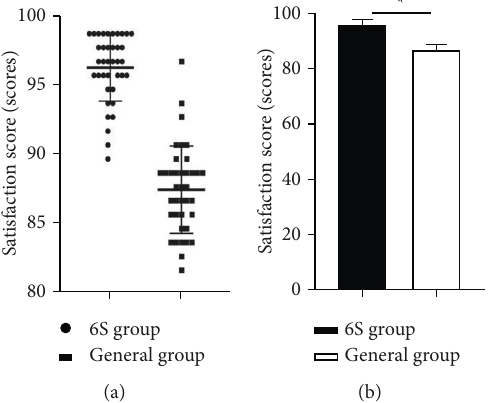
Figure 5: Analysis of the satisfaction of 38 healthcare workers with the sterilization of instruments. (a) Satisfaction score (scores). (b) Satisfaction score (scores). The 6S group compared to the general group, ∗ P > 0 .